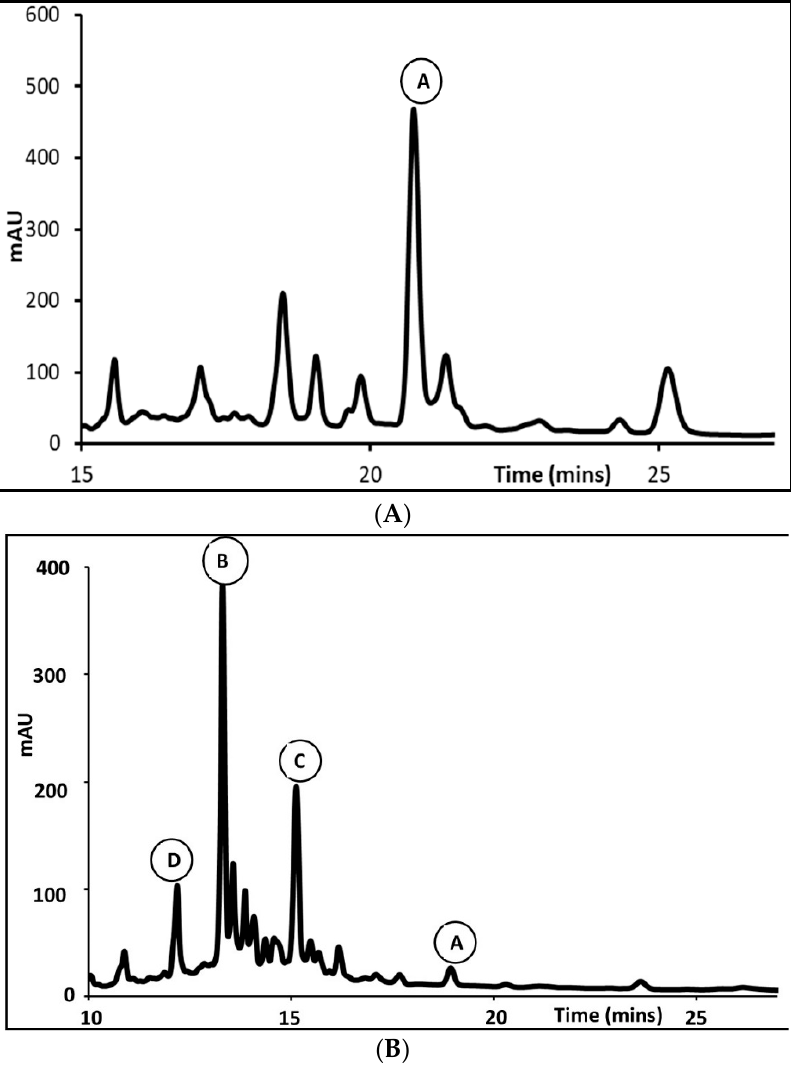
Figure 2. HPLC profile chromatograms (270 nm) of P. hadiensis var. hadiensis leaf ( A ) and stem ( B ) acetone extracts. Peak A: Roy (1); Peak B and Peak C are major compounds that appeared on